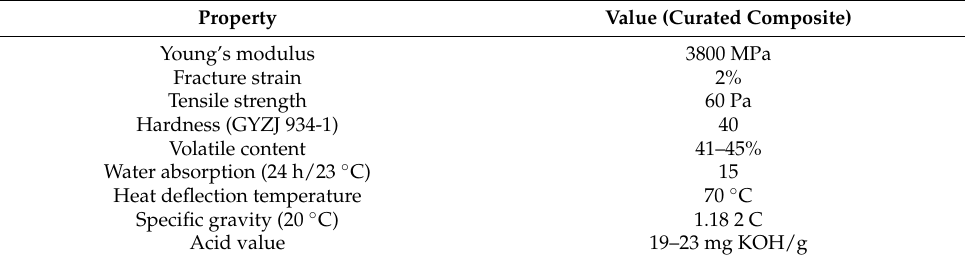
Table 3. Properties curated graphene-based resins.